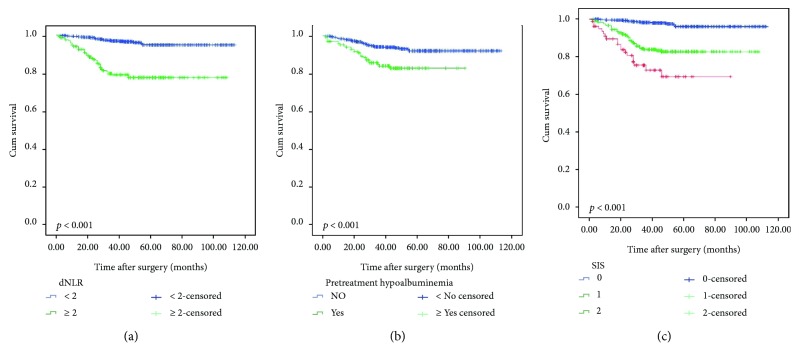
Kaplan-Meier curves for high versus low dNLR (a), with versus without pretreatment hypoalbuminemia (b), and patients according to different SIS (c) in the entire cohort.